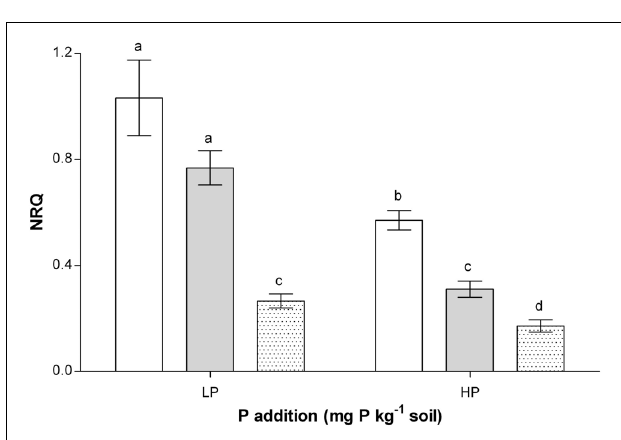
FIGURE 5 | Normalized relative quantity (NRQ) of MtMT4 in roots of non-mycorrhizal or mycorrhizal medic ( Medicago truncatula ) grown in pots with different phosphorus (P) levels, 10 and 20mgPkg − 1 soil (LP and HP, respectively) and with no arsenic (0As) or arsenic added to the soil at rates of 2.5 and 5mgAskg − 1 soil (2.5 and 5.0As). Data are presented as mean values ± SEM ( n = 10, except for treatment group NM, HP where n = 8).The interaction between inoculation and P application was significant ( P = 0.008). Non-mycorrhizal plants, open bars and plants colonized by Glomus intraradices gray bars and G. mosseae dotted bars. Same letters indicate no significant differences between treatment groups at the 5%